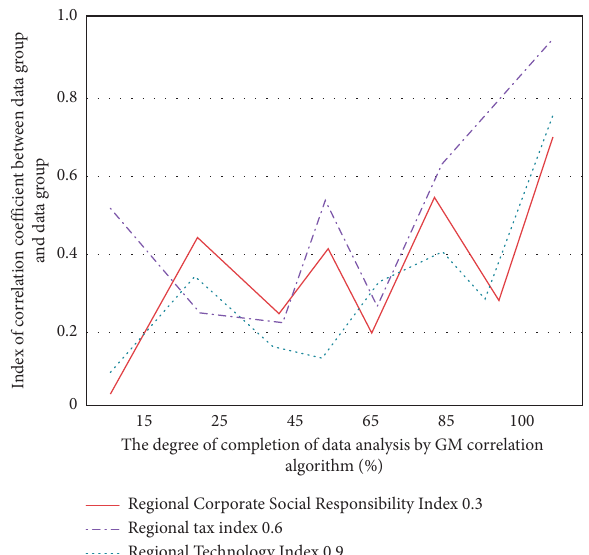
Figure 4: The GM correlation algorithm is the result of solving the correlation degree of the three sets of data under the analysis completion degree.